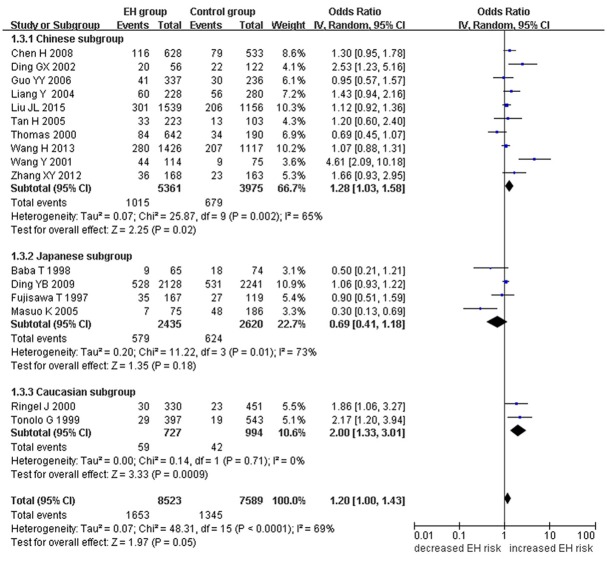
Forest plot of EH associated with ADRB3 gene Trp64Arg polymorphism under an additive genetic model (A vs. T).